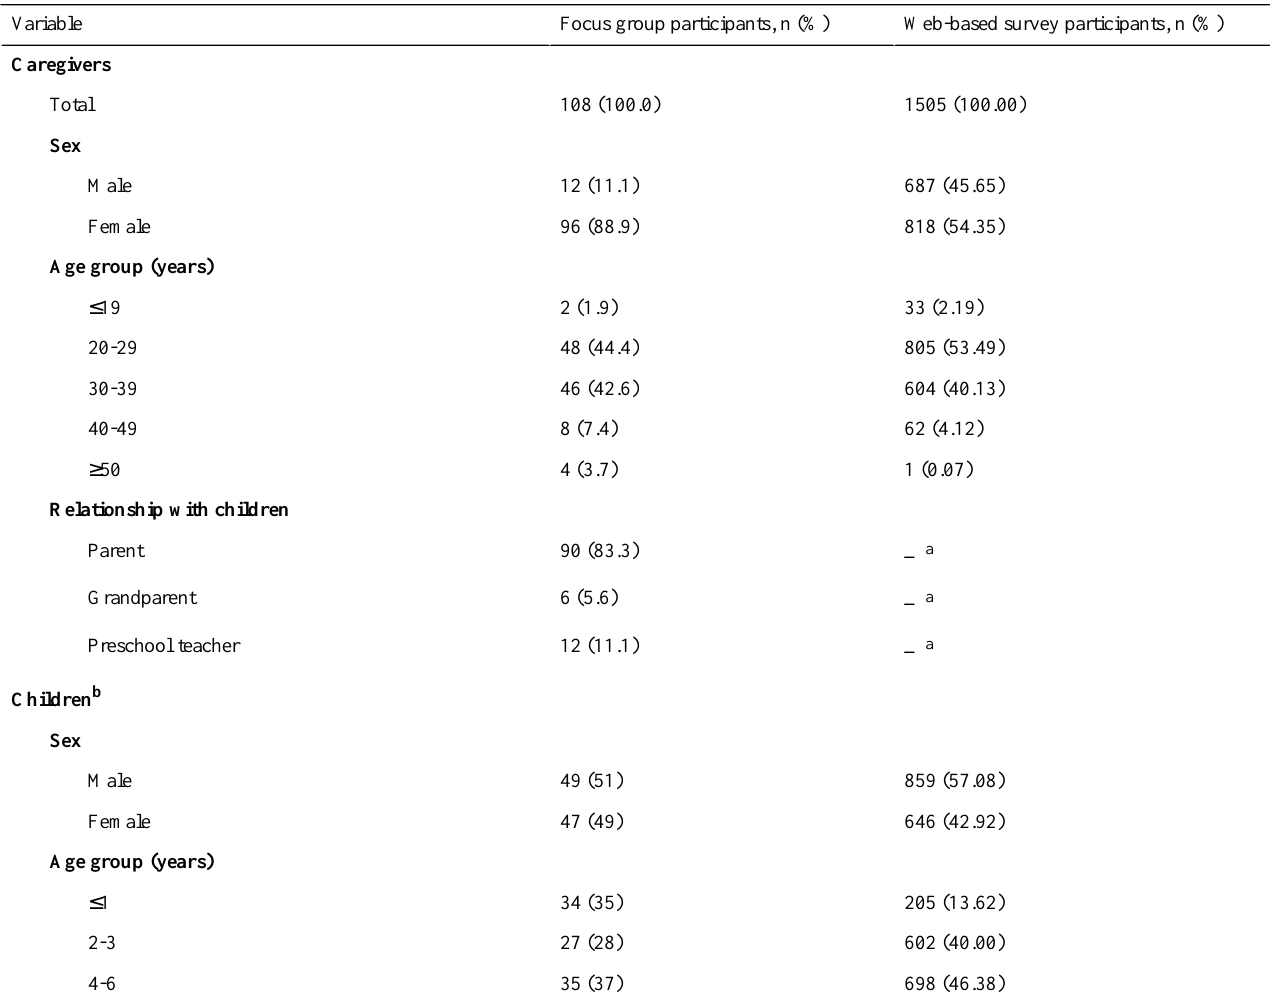
Table 1. Demographic characteristics of caregiver